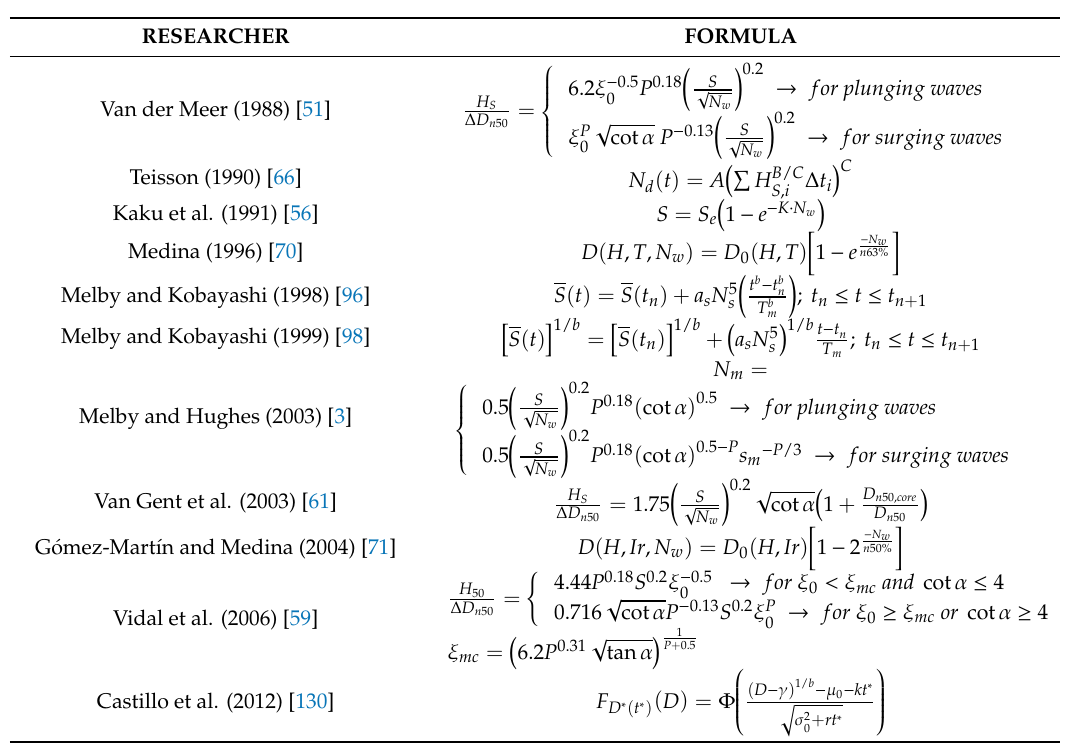
Table 2. Review of damage progression’s models. See Appendix B for the list of symbols.